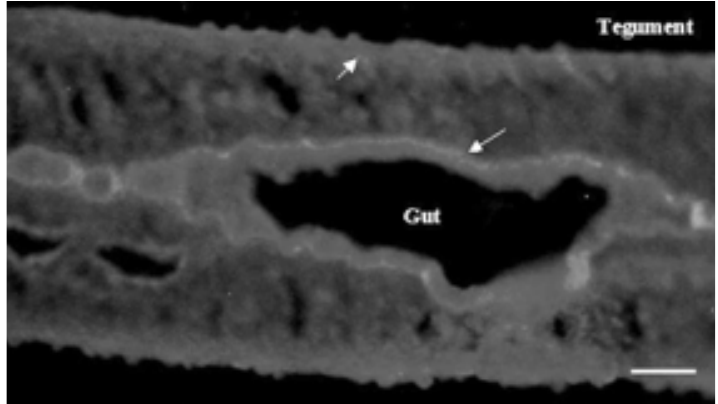
Figure 2. Localization of Sm14 by indirect immunofluorescence staining in adult worm cryosections. The sections reacted with rabbit anti-Sm14 polyclonal antibody diluted 1:100. The arrows indicate the basal lamella of the gut and of the tegument. Bar = 100